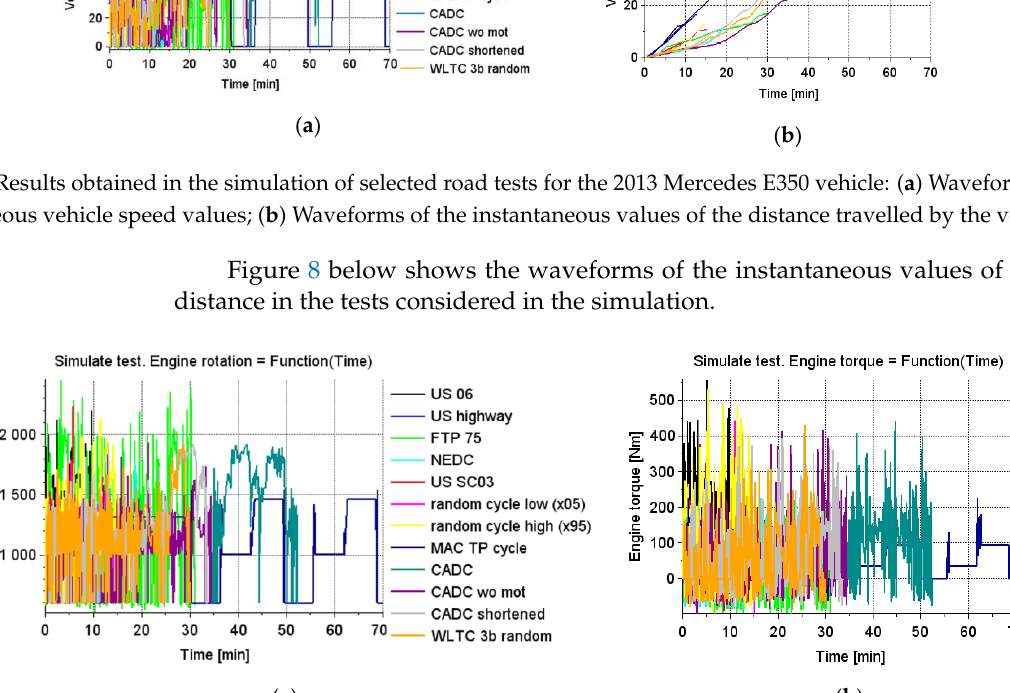
Figure 7. Results obtained in the simulation of selected road tests for the 2013 Mercedes E350 vehicle: ( a ) Waveforms of the instantaneous vehicle speed values; ( b ) Waveforms of the instantaneous values of the distance travelled by the vehicle.